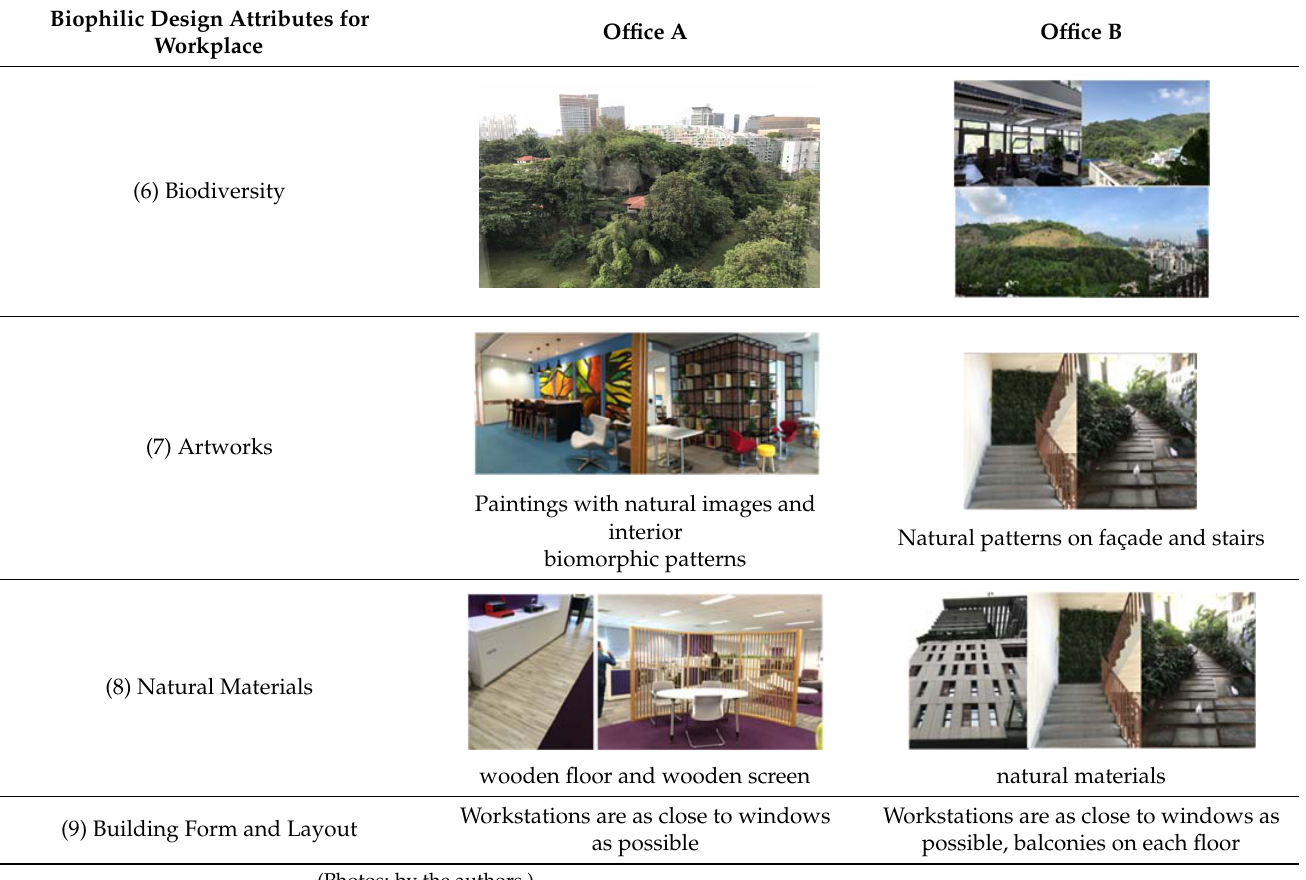
Table 7. Demographic information of survey respondents.